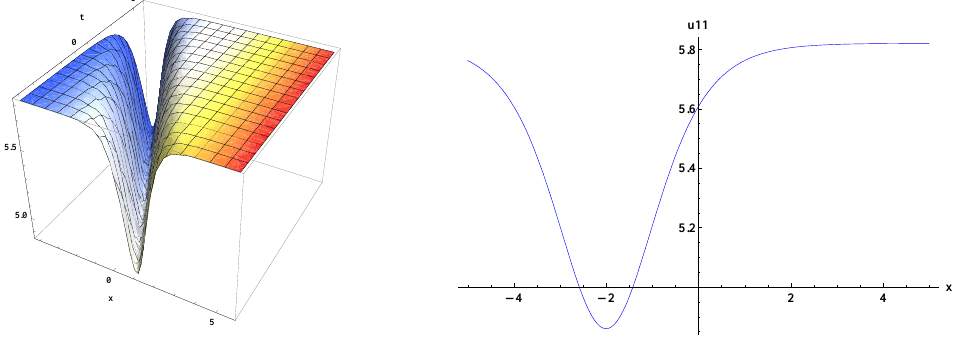
Figure 11. Dark wave solution (36) ( left ) and its projection at t = 0 ( right ), when K = 2, k = and y = 2.